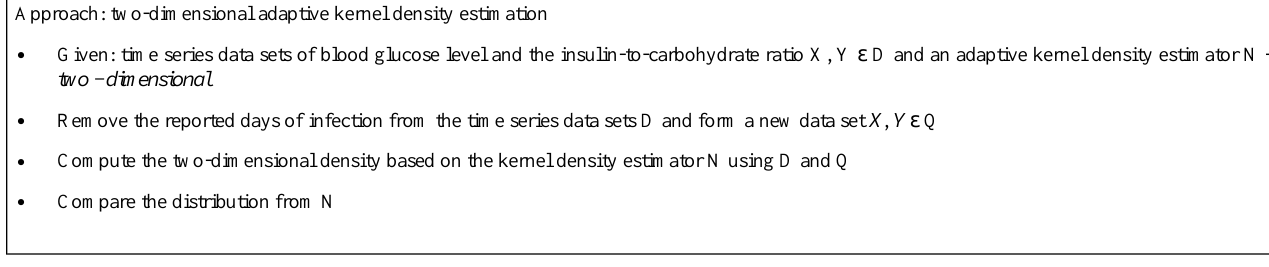
Textbox 2. Two-dimensional adaptive kernel density estimation. Approach: two-dimensional adaptive kernel density estimation